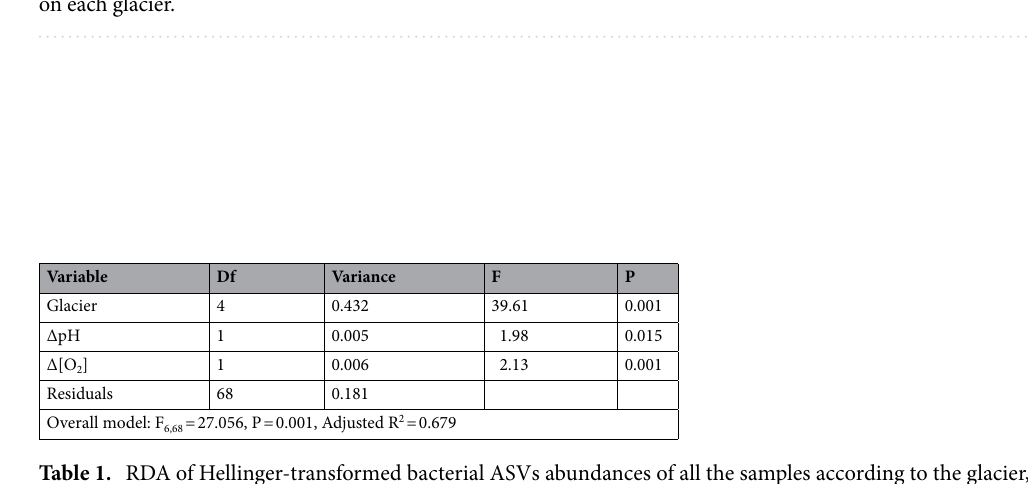
Table 1. RDA of Hellinger-transformed bacterial ASVs abundances of all the samples according to the glacier, pH and oxygen concentration centred according to their mean value per glacier.